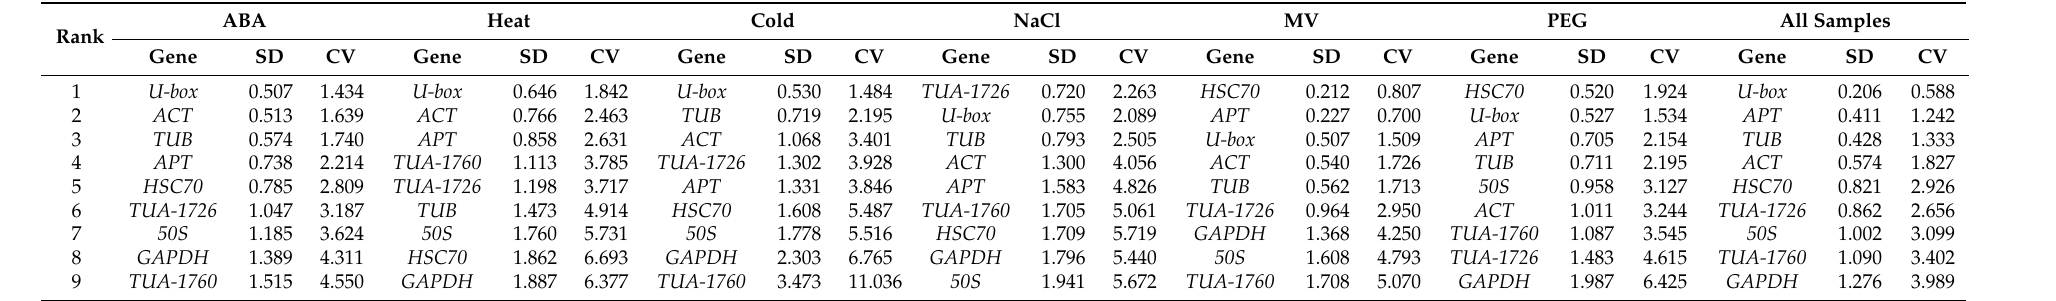
Table 3. Stability ranking of all sample genes calculated by BestKeeper